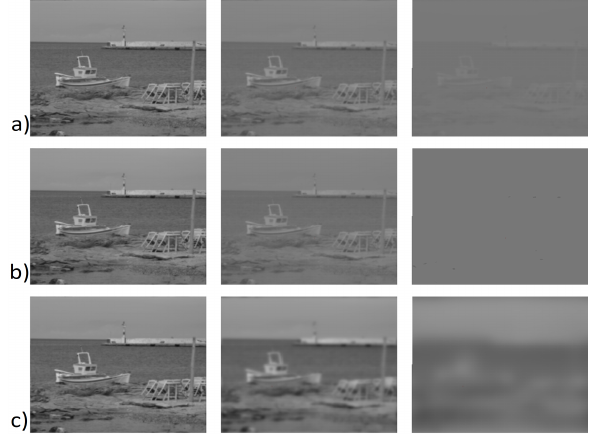
Figure 2. Modes of progressively degraded series of the stimulating images. The progression of experimental images' degradation is illustrated by third (1.00 FCT), eleventh (3.67 FCT) and twentieth (6.67 FCT) images from the sequences of twenty four images.